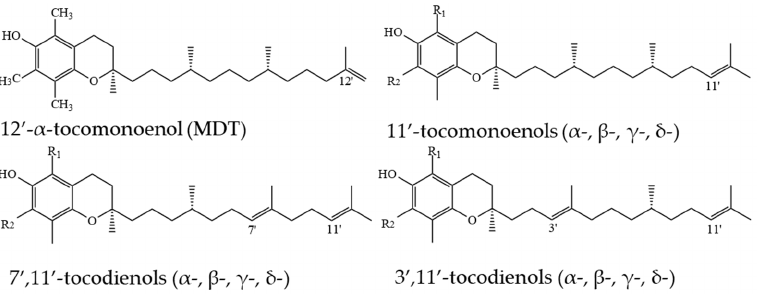
Figure 7. Selected richest sources of plastochromanol-8 (PC-8). Superscripts ( a–b ) refers to the fol- lowing literature positions: a , [65]; b , [15].